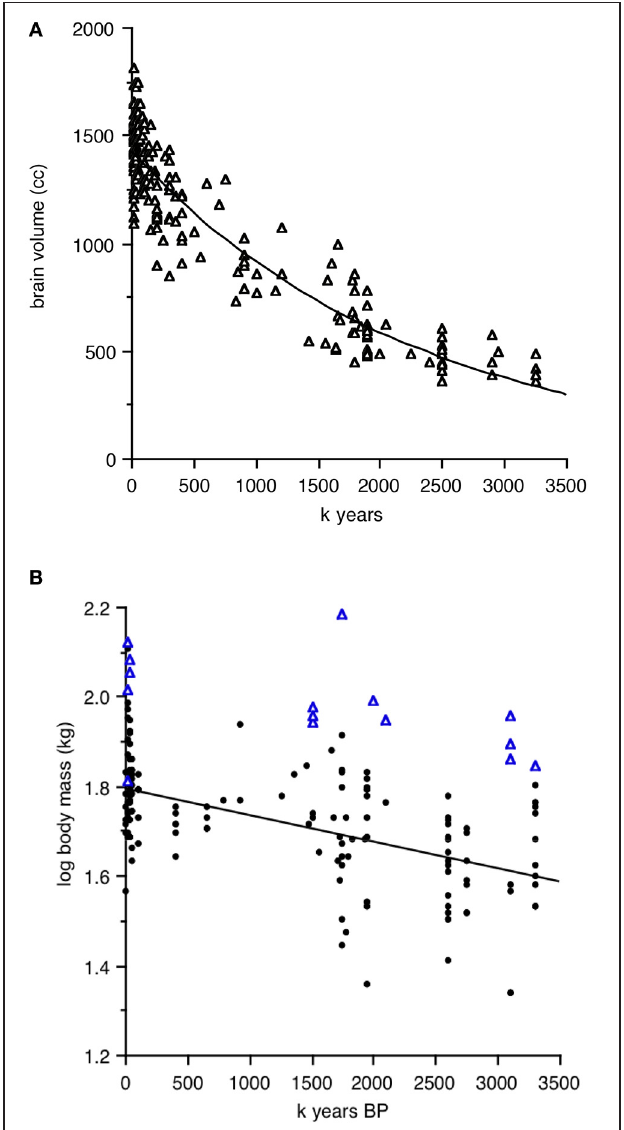
FIGURE 1 | Hominin brain and body size as a function of time from 3.2 million to 10,000 years BP. Data from Henneberg and colleagues, excluding robust species and data points for which species identity is uncertain. (A) Absolute brain size in cc. (B) Log transformed body size in kg; triangles in (B) represent very large